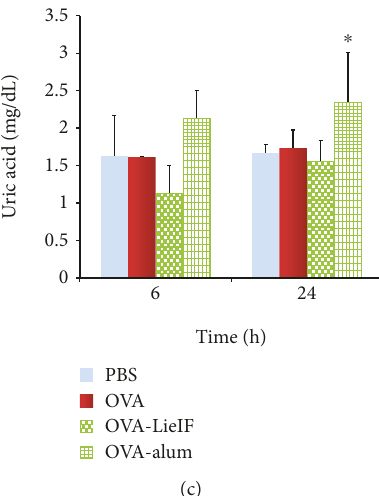
Figure 3: In vivo e ff ect of recombinant LieIF protein on the response of innate immune cells. (a) Schematic representation of the experimental protocol. Female BALB/c mice were i.p. injected in the right quadrant with 500 μ L of LieIF suspension (10 μ g/mouse) in sterile PBS containing equal quantity of OVA protein (10 μ g/mouse) (OVA-LieIF) or with 500 μ L of OVA suspension (10 μ g/mouse) in sterile PBS. Mice of the positive control received the known adjuvant alum (10 mg/mouse) in combination with OVA (10 μ g/mouse) (OVA-alum). Mice receiving only PBS were also included. Six and 24h after injection, the peritoneal exudate cells (PEC) were harvested with 5 mL of ice-cold PBS. (b) Recombinant LieIF protein recruits innate immune cells to the peritoneal cavity. Six and 24h after immunization, the peritoneal lavage was harvested and the percentages of neutrophils (Ly6G + -CD11b + ), monocytes (Ly6C + -CD11b + ), and macrophages (F4/80 + -CD11b + ) were determined by FACS. Results are presented in 2D line charts and in representative contour plots. ∗ indicates statistical di ff erence compared with the PBS-immunized mice (negative control group), and ∗∗ indicates statistical di ff erence compared to OVA-immunized mice. (c) The immunopotentiating e ff ect of LieIF does not depend on the production of uric acid. The levels of uric acid (mg/dL) were measured in serum of immunized mice using the enzymatic colorimetric uricase PAP method. The results are presented as the mean ± SD , and data shown are representative of three independent experiments. ∗ indicates statistically signi fi cant di ff erences as compared to the negative